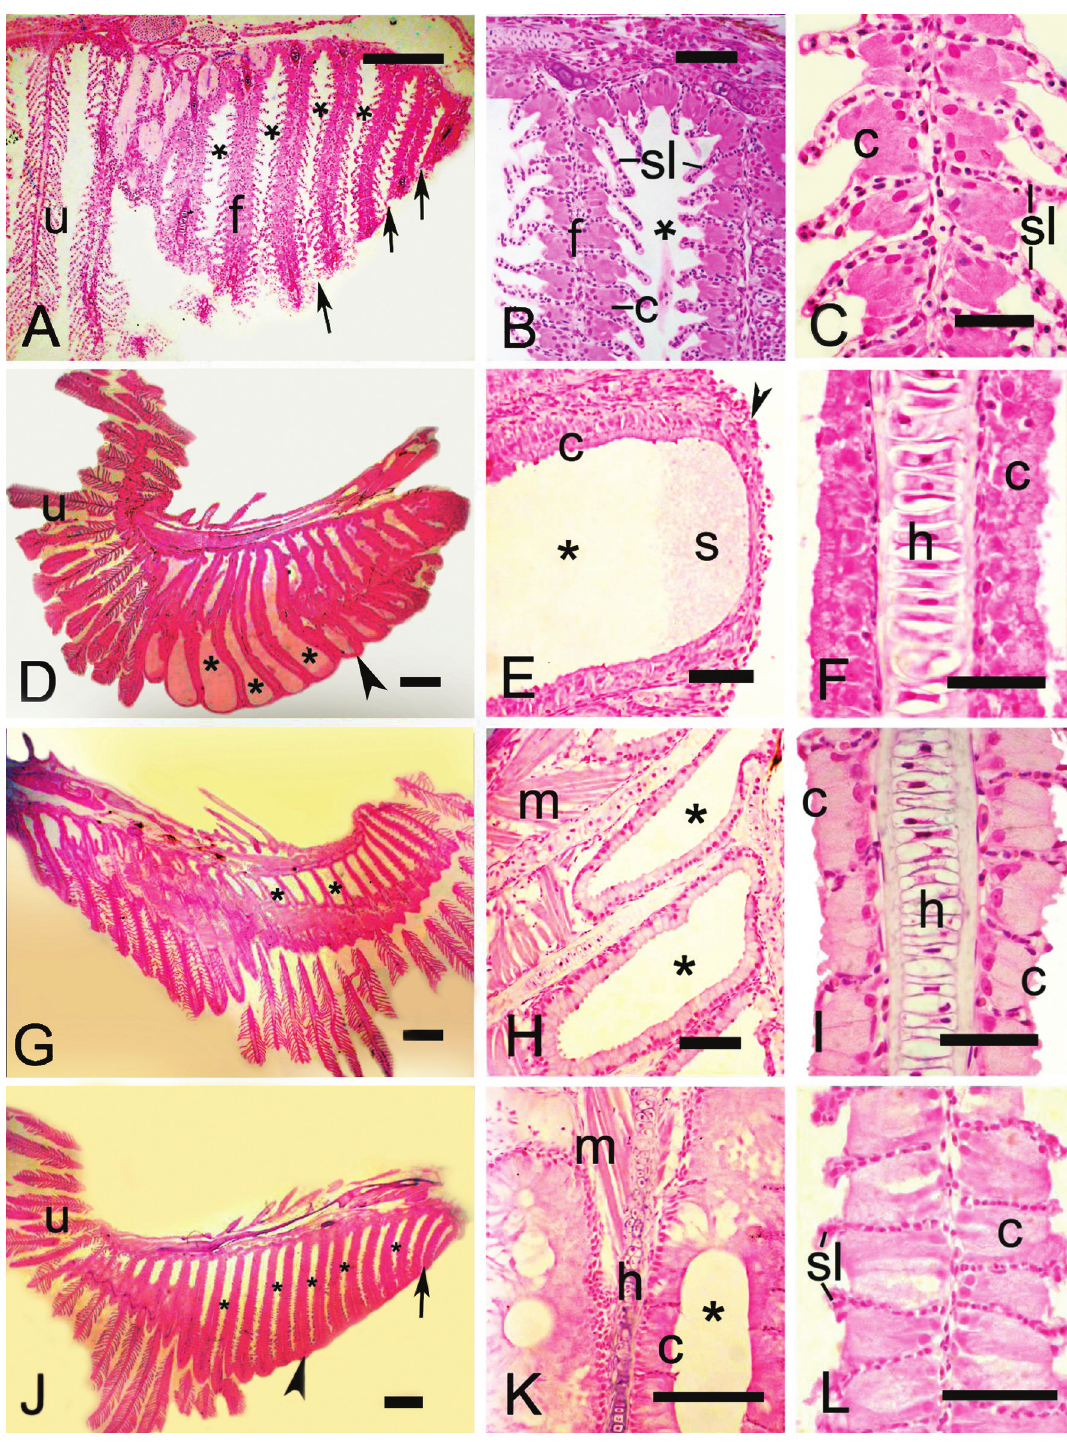
Fig. 3. Sagittal histological sections through first gill arches of males of the inseminating cheirodontines, ( A, B, C ) Acinocheirodon melanogramma , ( D, E, F ) Kolpotocheirodon theloura , ( G, H, I ) Macropsobrycon uruguayanae , and ( J, K, L ) Saccoderma hastata . Asterisk = lumen of gill gland chamber; c = columnar cells; f = gill filaments; sl = gill secondary lamellae; s = secretion; u = unmodified gill filaments; arrow = ventral opening of the chamber; arrowhead = gill gland cover; m = skeletal muscle; h = hyaline cartilage of gill filaments. Scale bars: 150 µm (A, D, G, J), 50 µm (B, E, H, K), 25 µm (C, F, I,